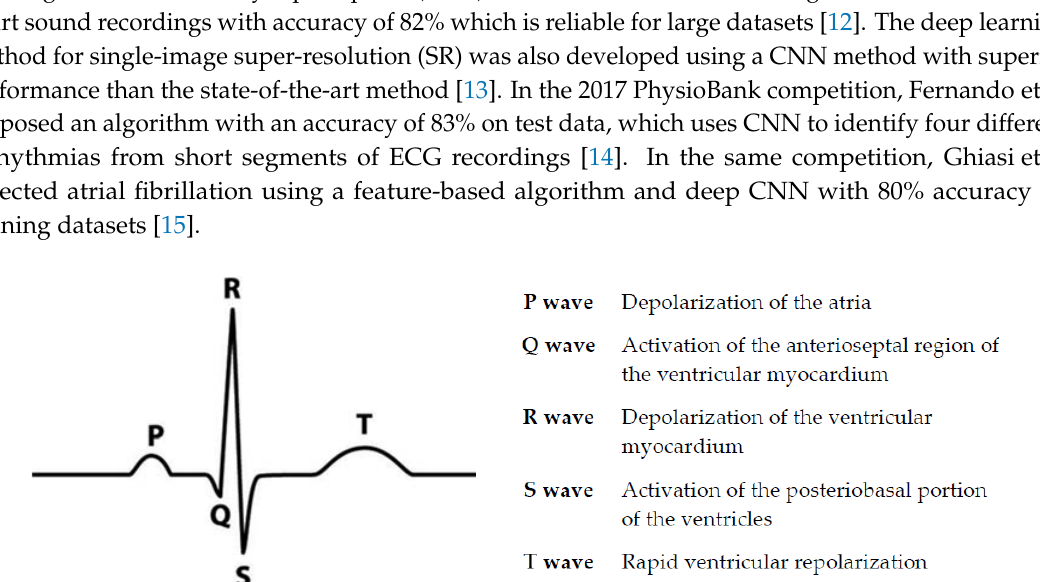
Figure 2. Comparison between simple neural network (NN) and deep NN; simple neural networks contain only one hidden layer as well as the input and output layers, while deep learning neural networks contain more than one hidden layer. In this case, there are four hidden layers between the input and output layers [17].